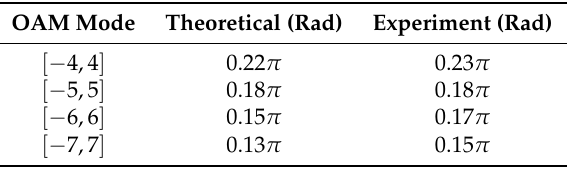
Figure 7. Azimuthal images of 1 (cid:93) corner-reflector target using different OAM mode ranges. Table 2. Comparisons of main-lobe width using different mode